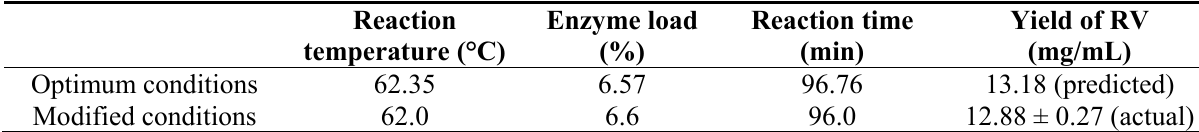
Table 4. Optimum conditions and the predicted and experimental value of response at the optimum